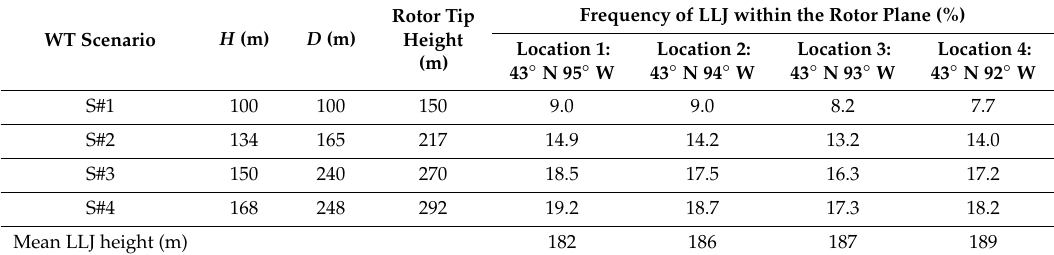
Table 4. Frequency (i.e., percent of all hours) during which a low-level jet (LLJ) maximum is present within the WT rotor plane by location and WT scenario. Also shown is the mean height of the LLJ wind speed maximum by location across the